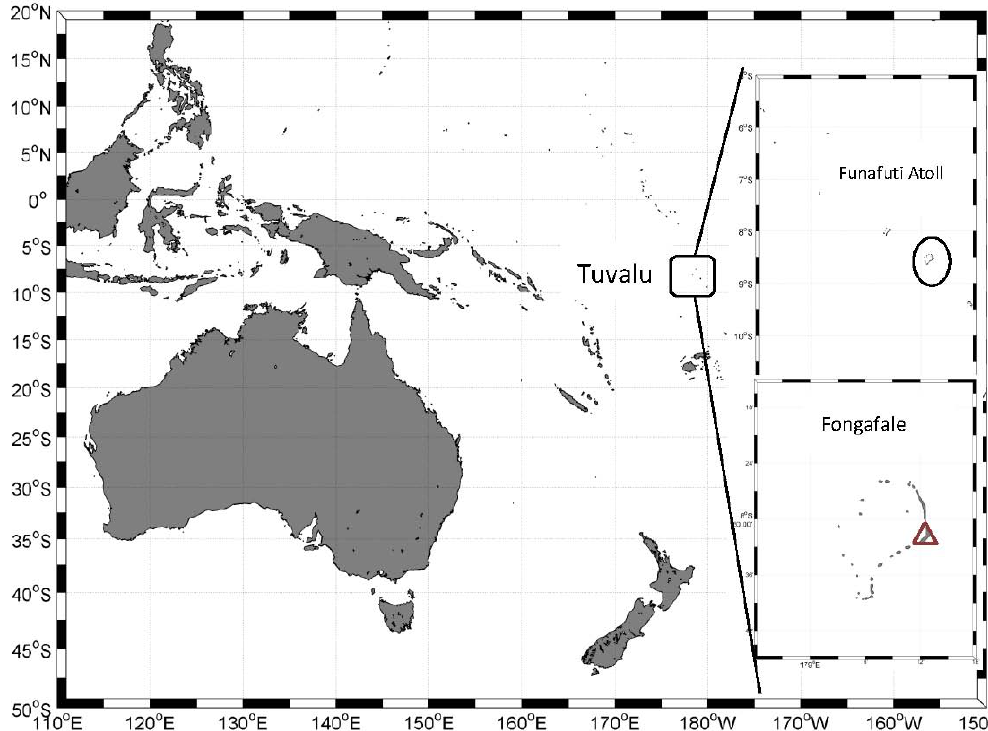
Fig. 1. The relative position of Australia and Tuvalu (left map). The upper right map is the relative position of nine Tuvalu atolls. Fongafale (bottom of right corner), the study site, is shown by red